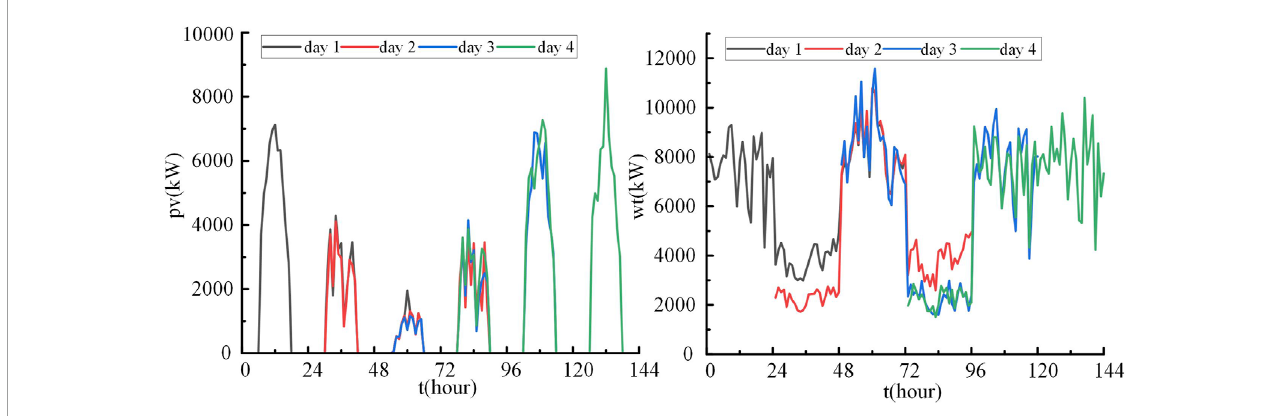
FIGURE 6 PV and WT forecast information.